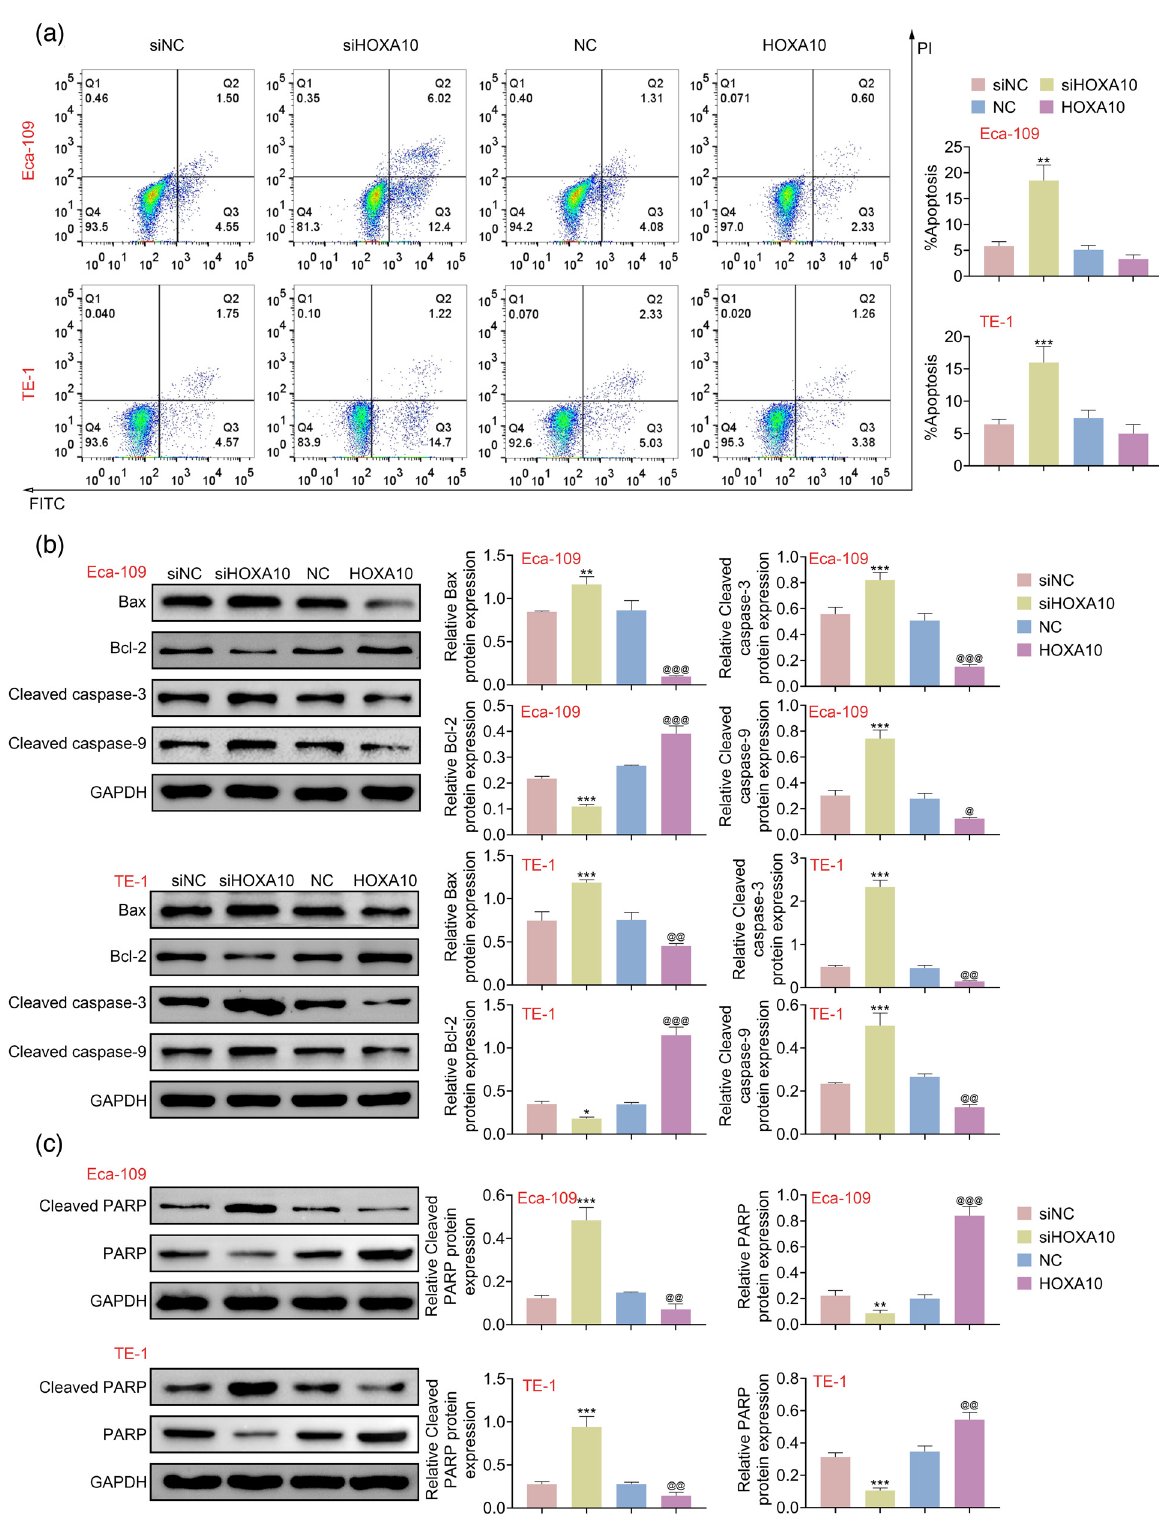
Figure 3: Overexpression of HOXA10 suppressed cell apoptosis in EC cells. ( a ) The siHOXA10 increased apoptosis rate of Eca - 109 and TE - 1 cells and overexpression of HOXA10 increased apoptosis rate. Annexin V - FITC assay was used to measure cell apoptosis. ( b ) The apoptosis - related proteins containing Bax, Bcl - 2, cleaved caspase - 3, and cleaved caspase - 9 were determined by western blot Eca - 109 and TE - 1 cells. ( c ) The cleaved PARP and PARP protein levels were assessed by western blot. Each experiment repeated three times. * p < 0.05, ** p < 0.01, *** p < 0 .001 vs NC. @ p < 0.05, @@ p < 0.01, @@@ p < 0.001 vs